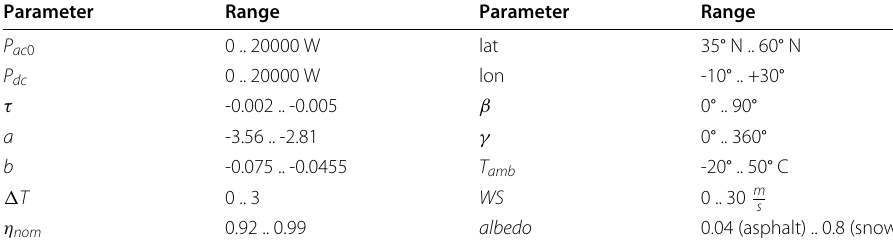
Table 4 Parameter bounds for sensitivity